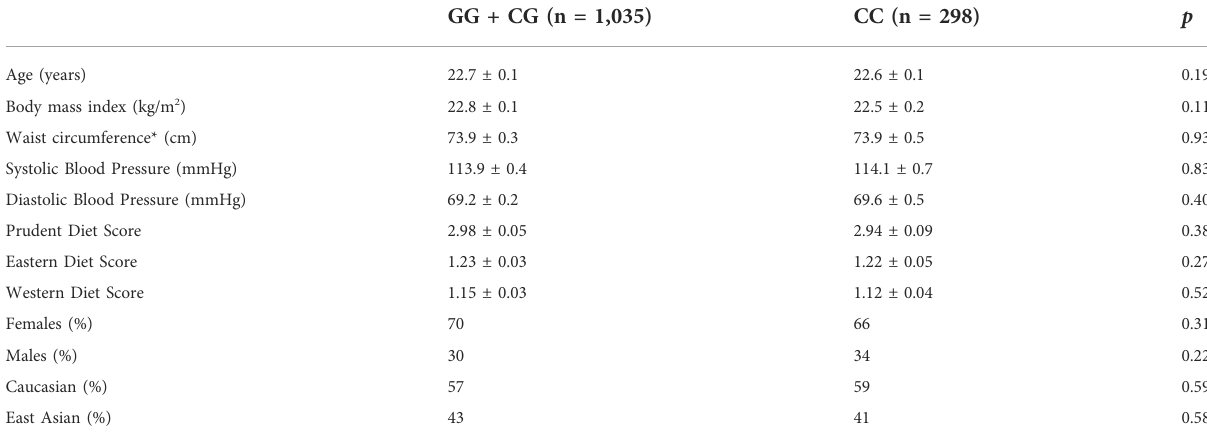
TABLE 1 Subject characteristics according to 9p21 genotype